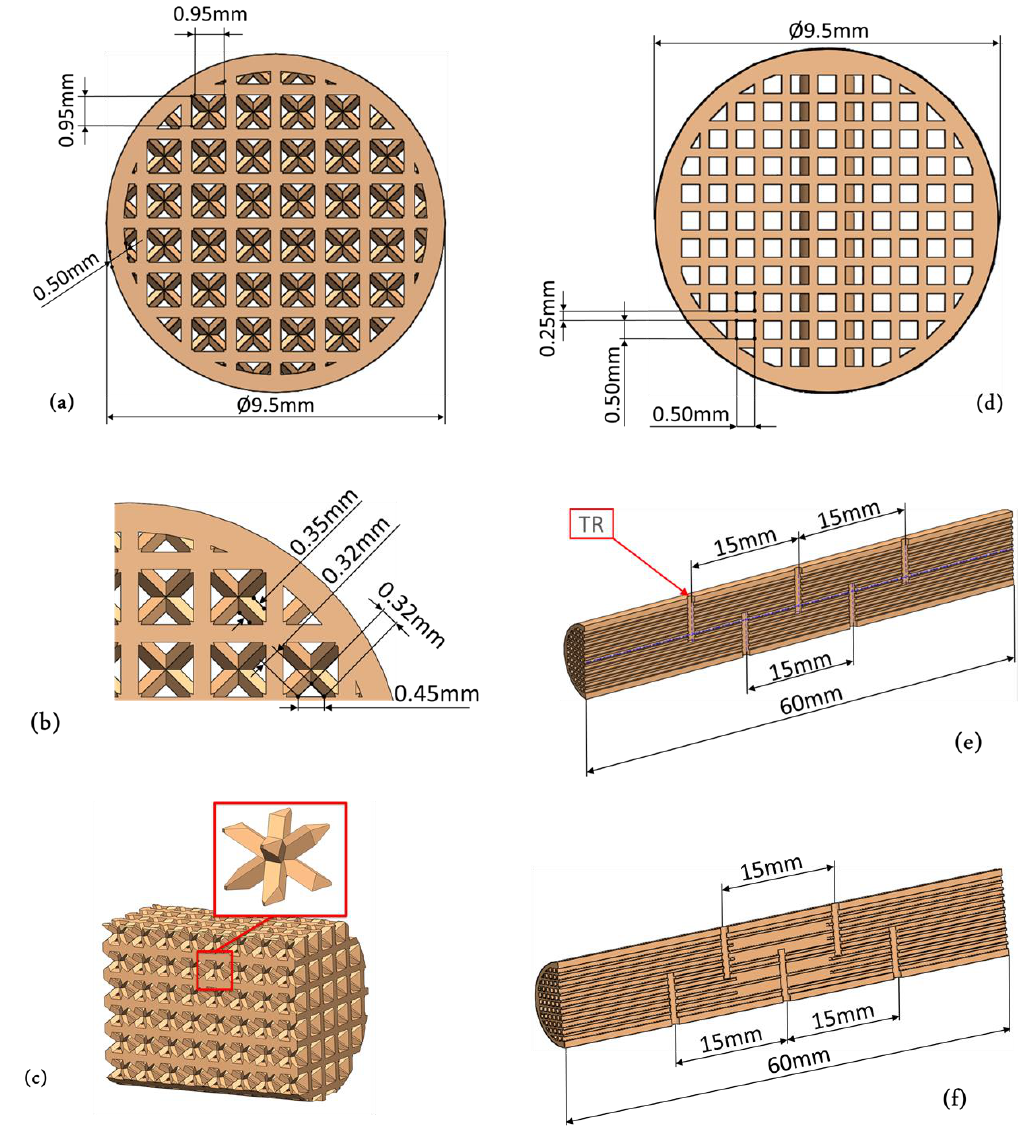
Figure 2. Drawings of different regenerators tested. ( a ) Front view of Str_30%. ( b ) Structure close-up of Str_30%. ( c ) Isometric view of Str_30%. ( d ) Front view of 35% and 40%. ( e ) Isometric view of 35%. ( f ) Isometric view of Str_40%. TR: microthermocouples planned.